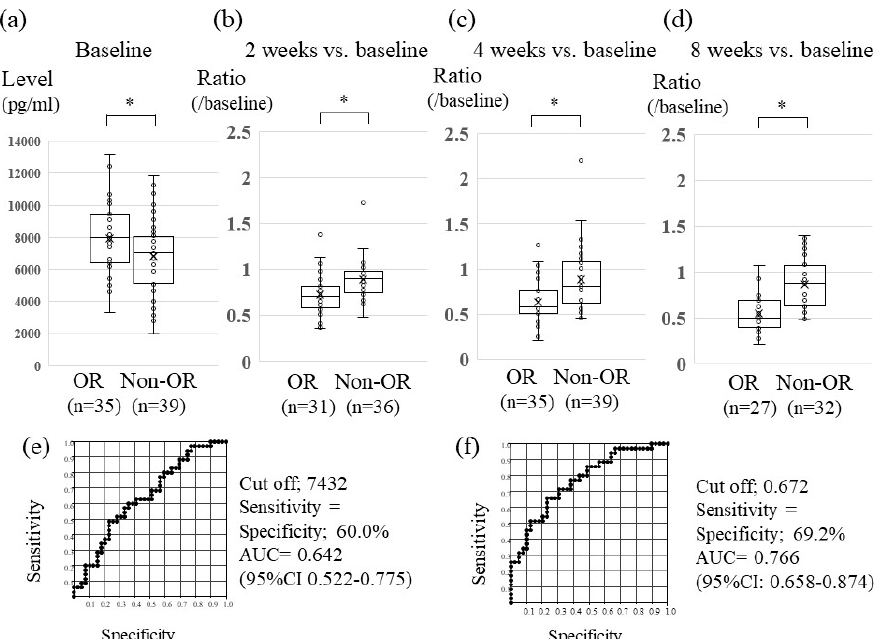
Figure 2. Association between serum Ang-2 level and Lenvatinib treatment response. Distribution of serum angiopoietin-2 (Ang-2) levels at baseline ( a ), and ratio of Ang-2 levels versus baseline at 2 weeks ( b ), 4 weeks ( c ), and 8 weeks ( d ) between the OR (objective response) and non-OR groups. Data are shown as median values (10th–90th percentile ranges). The Mann-Whitney or Kruskal-Wallis test was used to determine statistical significance. * p < 0.05, N.S: non-significant. ROC analyses of the level of Ang-2 at baseline ( e ) and the Ang-2 ratio at 4 weeks/baseline ( f ) for differentiating patients in the OR group versus the non-OR group . AUC, area under the ROC curve.